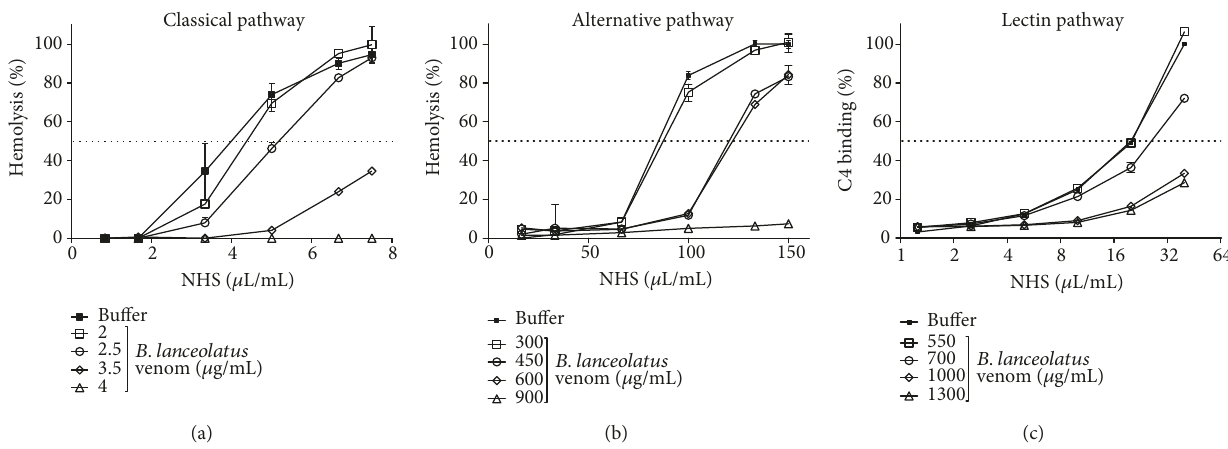
Figure 1: Activation of the three Complement pathways by B. lanceolatus venom. NHS (dilution 1:80 (a), 1:4 (b), and 1 :25 (c)) was incubated with several concentrations of B. lanceolatus venom at 37 ° C for 1h (CP) or 30min (AP and LP), and diluted to test their residual Complement activity. NHS incubated only with bu ff er was used as control. (a) Sensitized sheep erythrocytes were used to assess the CP while (b) rabbit erythrocytes (E ) were used for the AP. (c) For the LP, residual binding of C4 on a mannan-coated plate was used. R The results represent mean ± SD of duplicates of a representative assay. Experiments were performed three times. The CH LP were calculated by nonlinear regression from these curves. The IC of the venom for each pathway and respective CI95% were 50 50 calculated. The venom a ff ected the classical pathway with an IC of 156.6 μ g/mL of NHS (CI95%: 147.3 – 166.6 μ g/mL of NHS), the 50 alternative pathway with an IC of 294.5 μ g/mL of NHS (CI95%: 273.2 – 317.4 μ g/mL of NHS), and the LP pathway with an IC 50